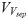
Validation on artificial images.(A) Illustration of an artificial test image with sampling strategy. (B-C) Macro results for VVsep * and Lm† plotted against the theoretical values. The regression line is plotted in red, dashed line represents identity (y = x). (D-E) Bland-Altman plots for VVsep * and Lm† plot the relative difference [(theoretical–macro)/average] to the average result. Red line indicates bias, with confidence interval (dashed red line). *volume density of alveolar septa (VVsep); †mean linear intercept of the airspaces (Lm).